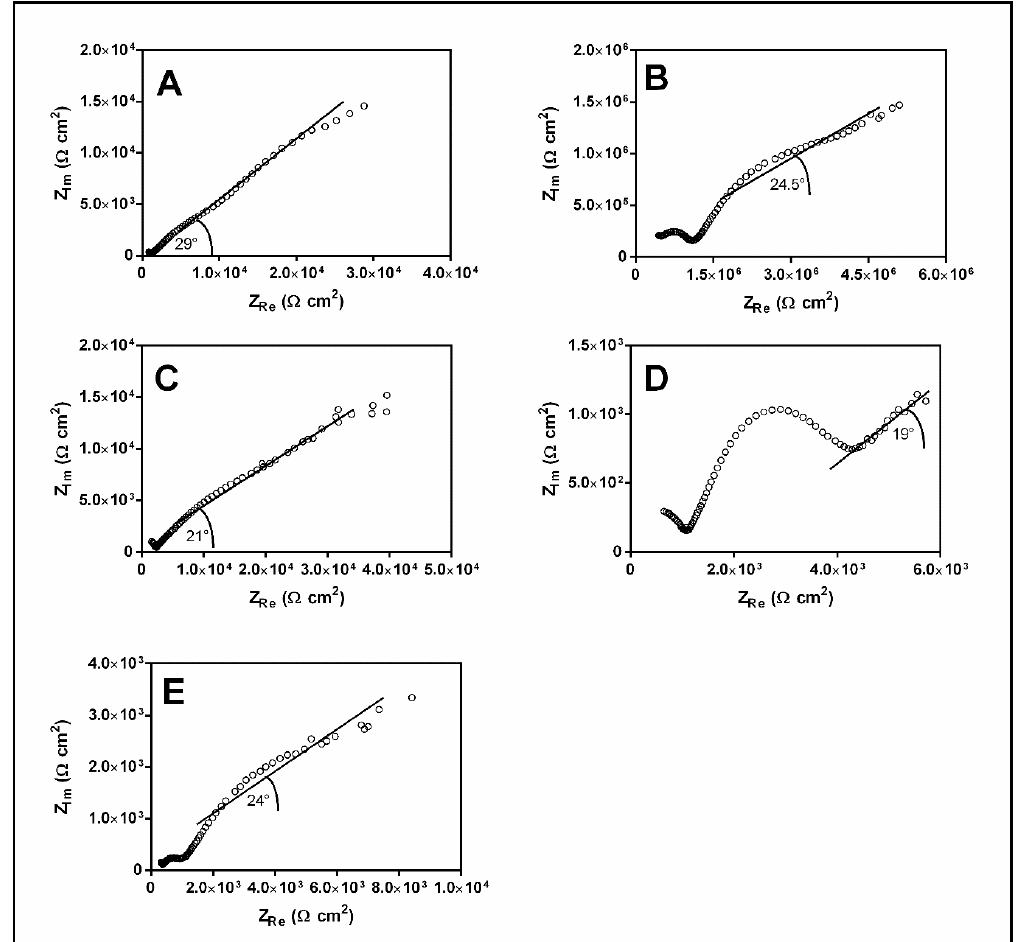
Figure 6. Summary of more representative electrochemical impedance results of samples exposed to ( A ) 1 month, ( B ) 3 months, ( C ) 8 months, ( D ) 12 months, and ( E ) 24 months of aging.